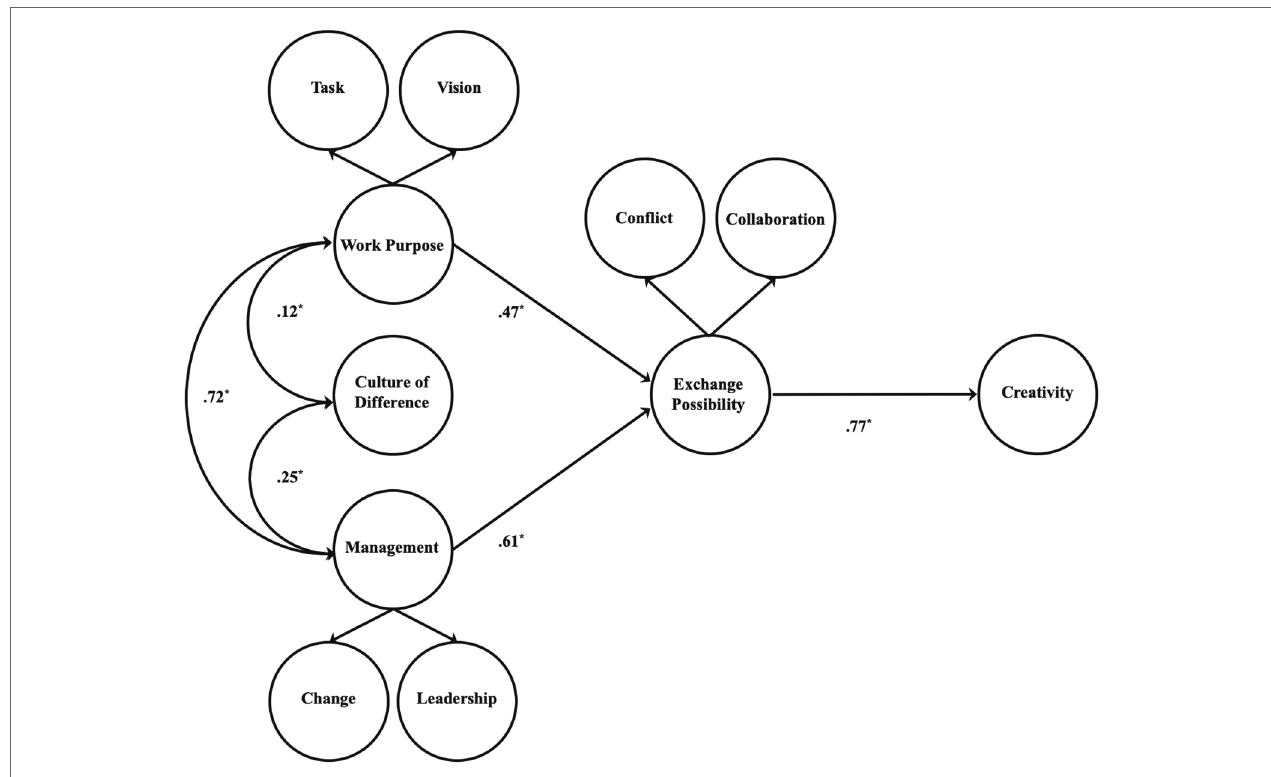
FIGURE 2 | Living and working together final